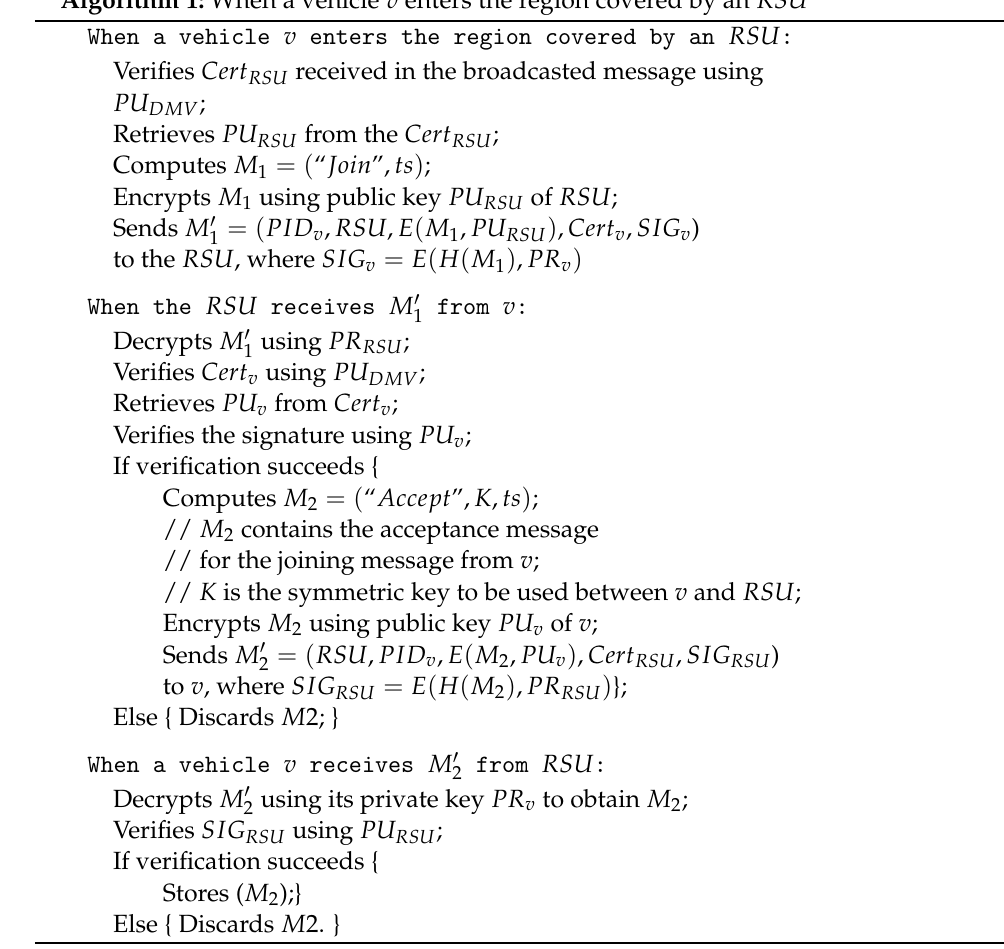
Algorithm 1: When a vehicle v enters the region covered by an